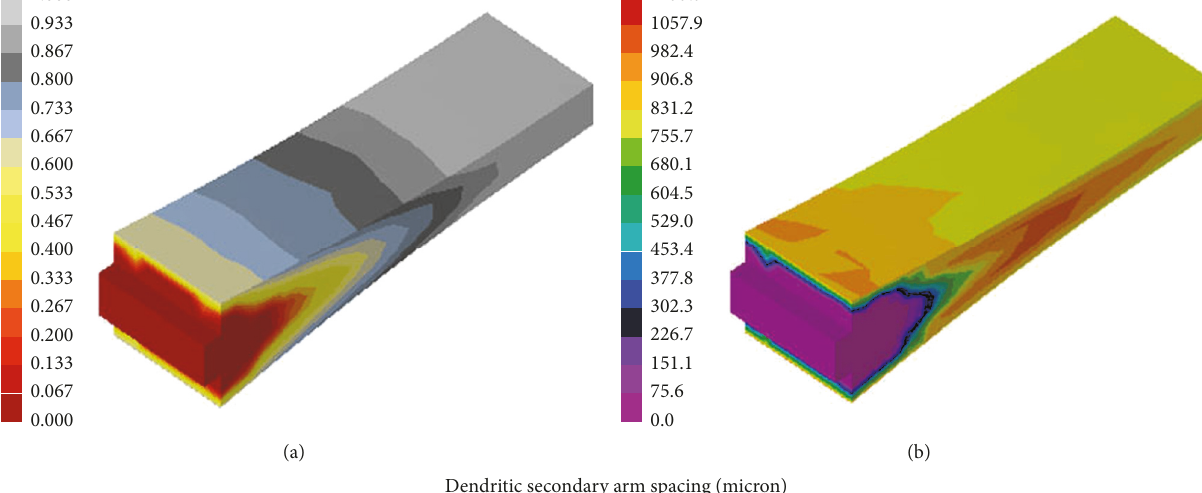
Table 3: Tensile properties of twin-roll cast Al-10Mg plate.